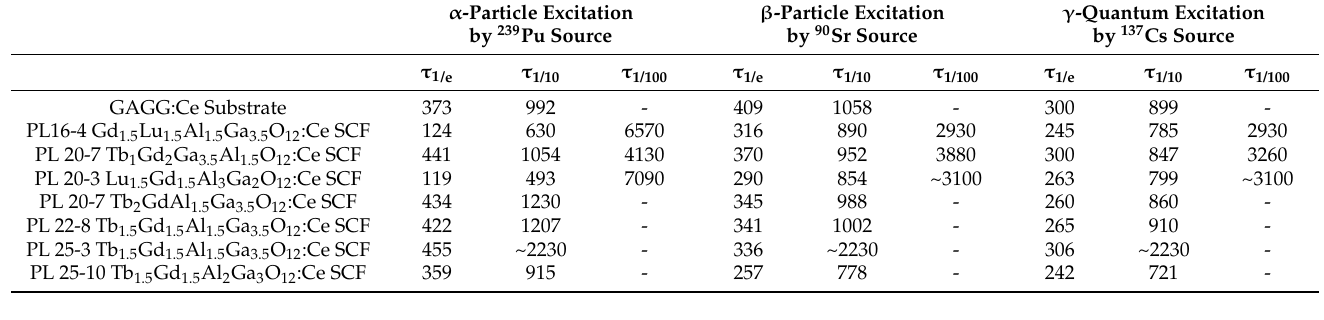
Table 4. Scintillation decay parameters of (Gd,Lu,Tb) 3 (Al,Ga) 5 O 12 :Ce SCF / GAGG:Ce SC composite scintillators under different types of excitation. A dash indicates no registered attenuation at this level within the 8000 ns measurement range. α -Particle Excitation β -Particle Excitation γ -Quantum Excitation by 239 Pu Source by 90 Sr Source by 137 Cs Source τ 1/e τ 1/10